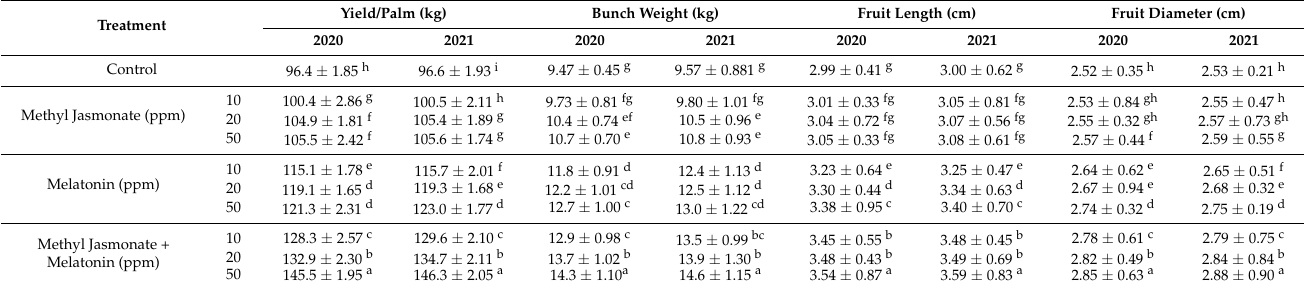
Table 2. Effects of foliar application of melatonin and/or methyl jasmonate solutions at different concentrations on the yield and its components of date palm trees (cv. Barhi) at the harvest time *.